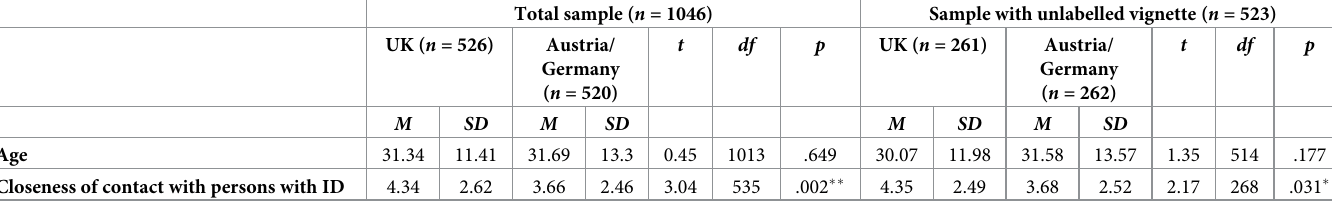
Table 2. Sociodemographic characteristics and results of t-tests for differences between Austria/Germany and